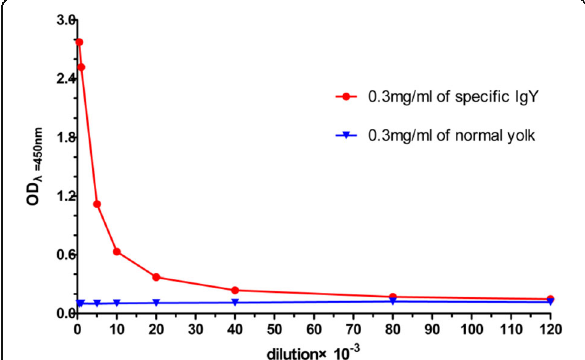
Fig 4 Titer profile of IgY raised against D. acutus venom by ELISA.